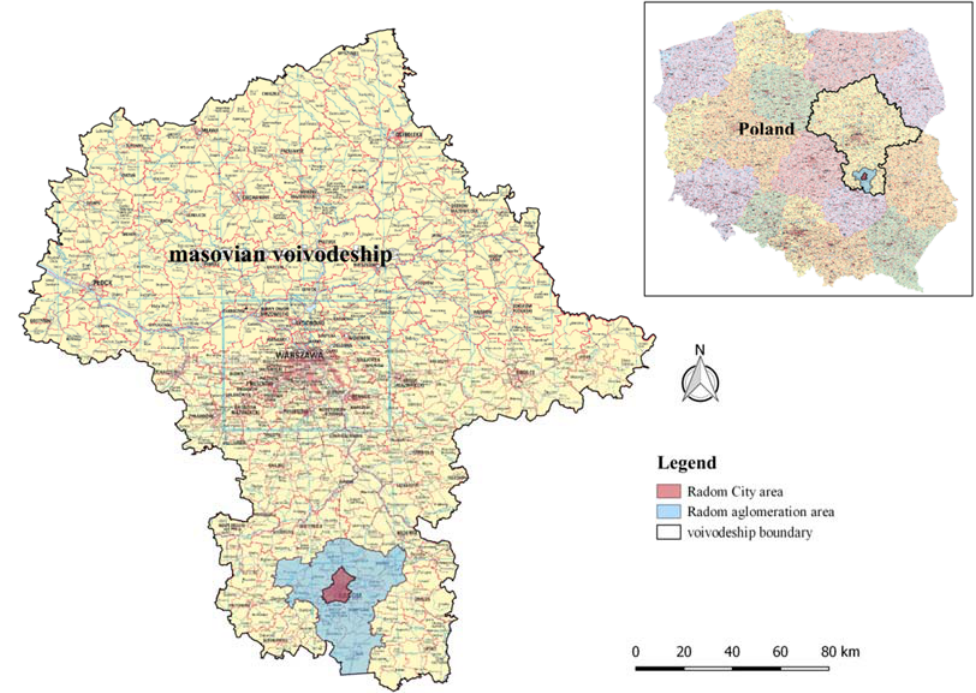
Figure 1. The location of the rural agglomeration of Radom against the background of the Masovian Voivodeship and Poland.